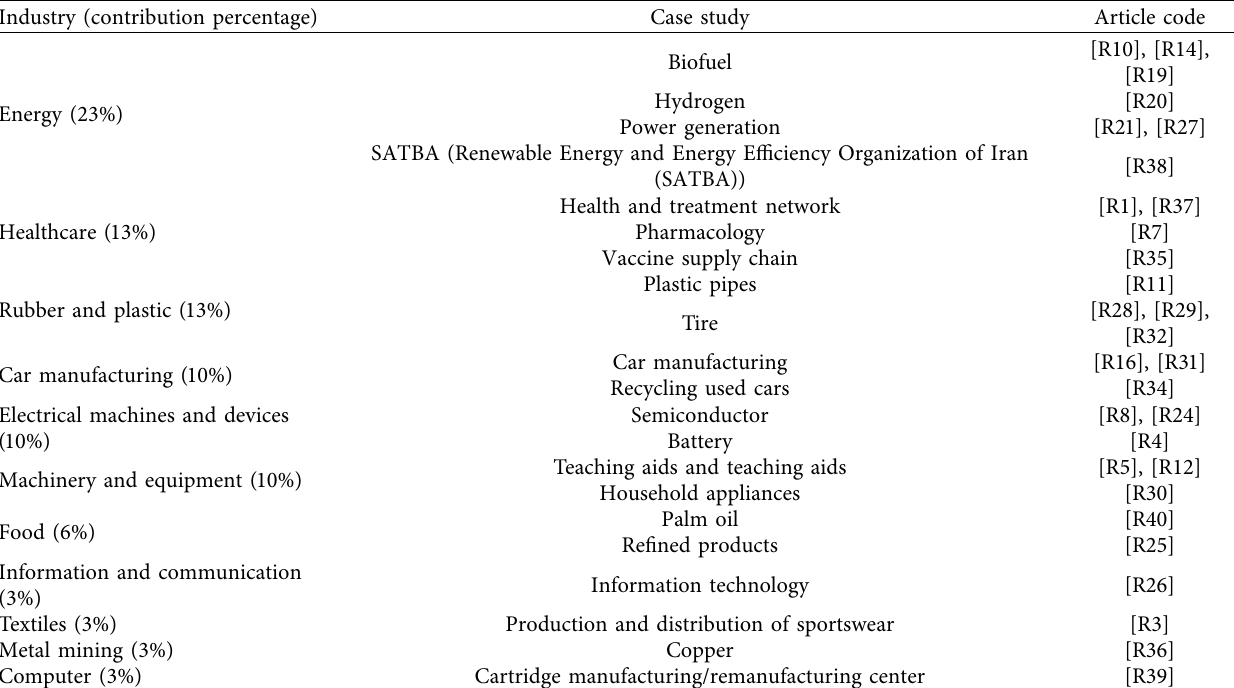
Table 8: Distribution of study cases by